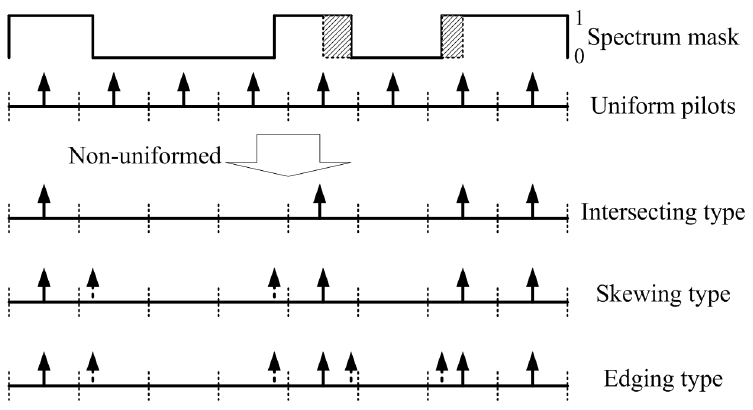
Figure 2. Non-uniform pilot design for TDCS.